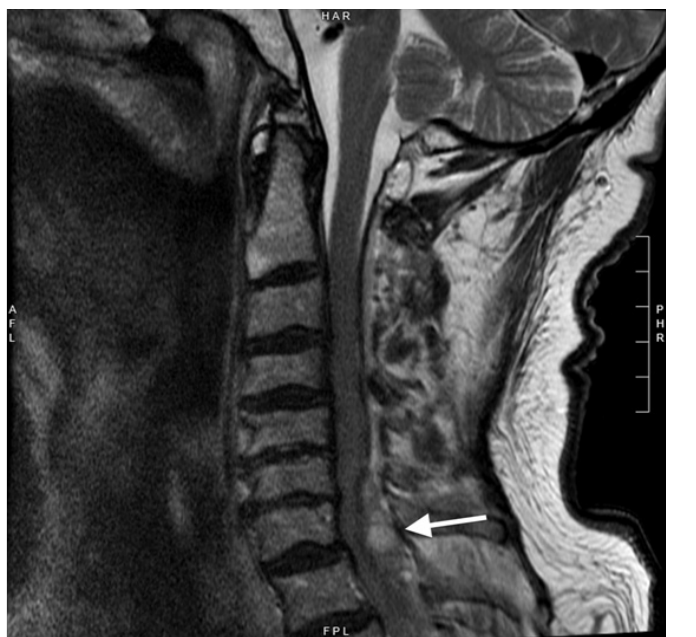
Image 2. Sagittal T2-weighted, non-contrast magnetic resonance imaging of the cervical spine showing hyperintense dorsal epi- dural hematoma with cord compression most pronounced at the seventh cervical vertebra